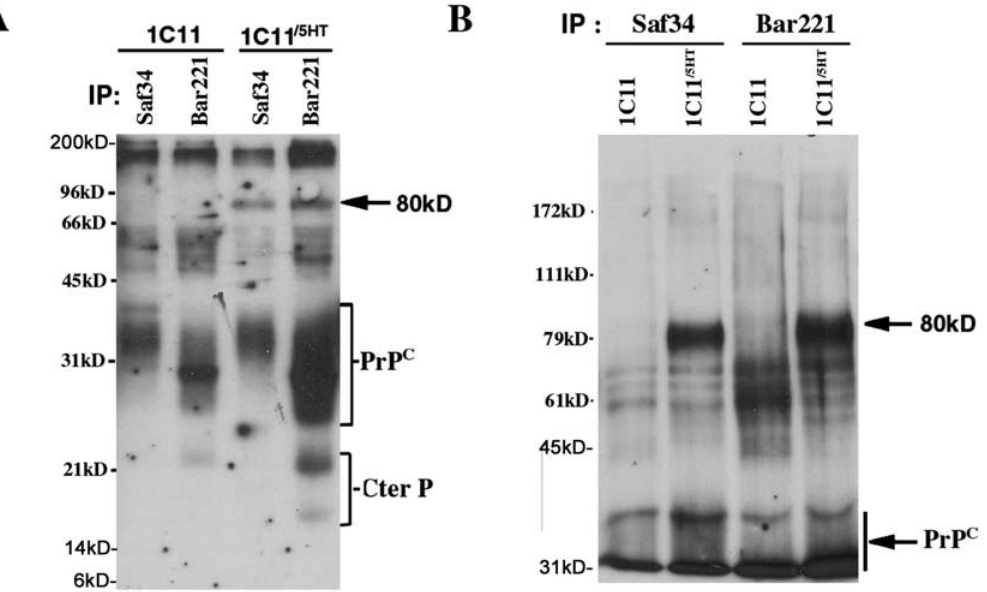
Figure 3. PrP C interacts with a 80 kDa protein in microdomains of 1C11 5-HT and 1C11 NE neuronal cells. Lipid rafts from 1C11 5-HT , 1C11 NE and 1C11 precursor cells were prepared after biotinylation of membrane proteins. PrP C was immunoprecipitated either with an anti-N-ter monoclonal antibody (SAF34) or an anti-C-ter antibody (Bar221) covalently linked to sepharose beads. The biotinylated PrP C complexes were separated on a 12% SDS-PAGE to visualize all the PrP C species (A) and on an 8% gel to better separate PrP C co-immunoprecipitated protein of higher apparent molecular mass (B). Biotinylated proteins were revealed with streptavidin peroxidase conjugate. The 80 kDa protein that co-immunoprecipitates with PrP C in 1C11 5-HT is indicated by an arrow.